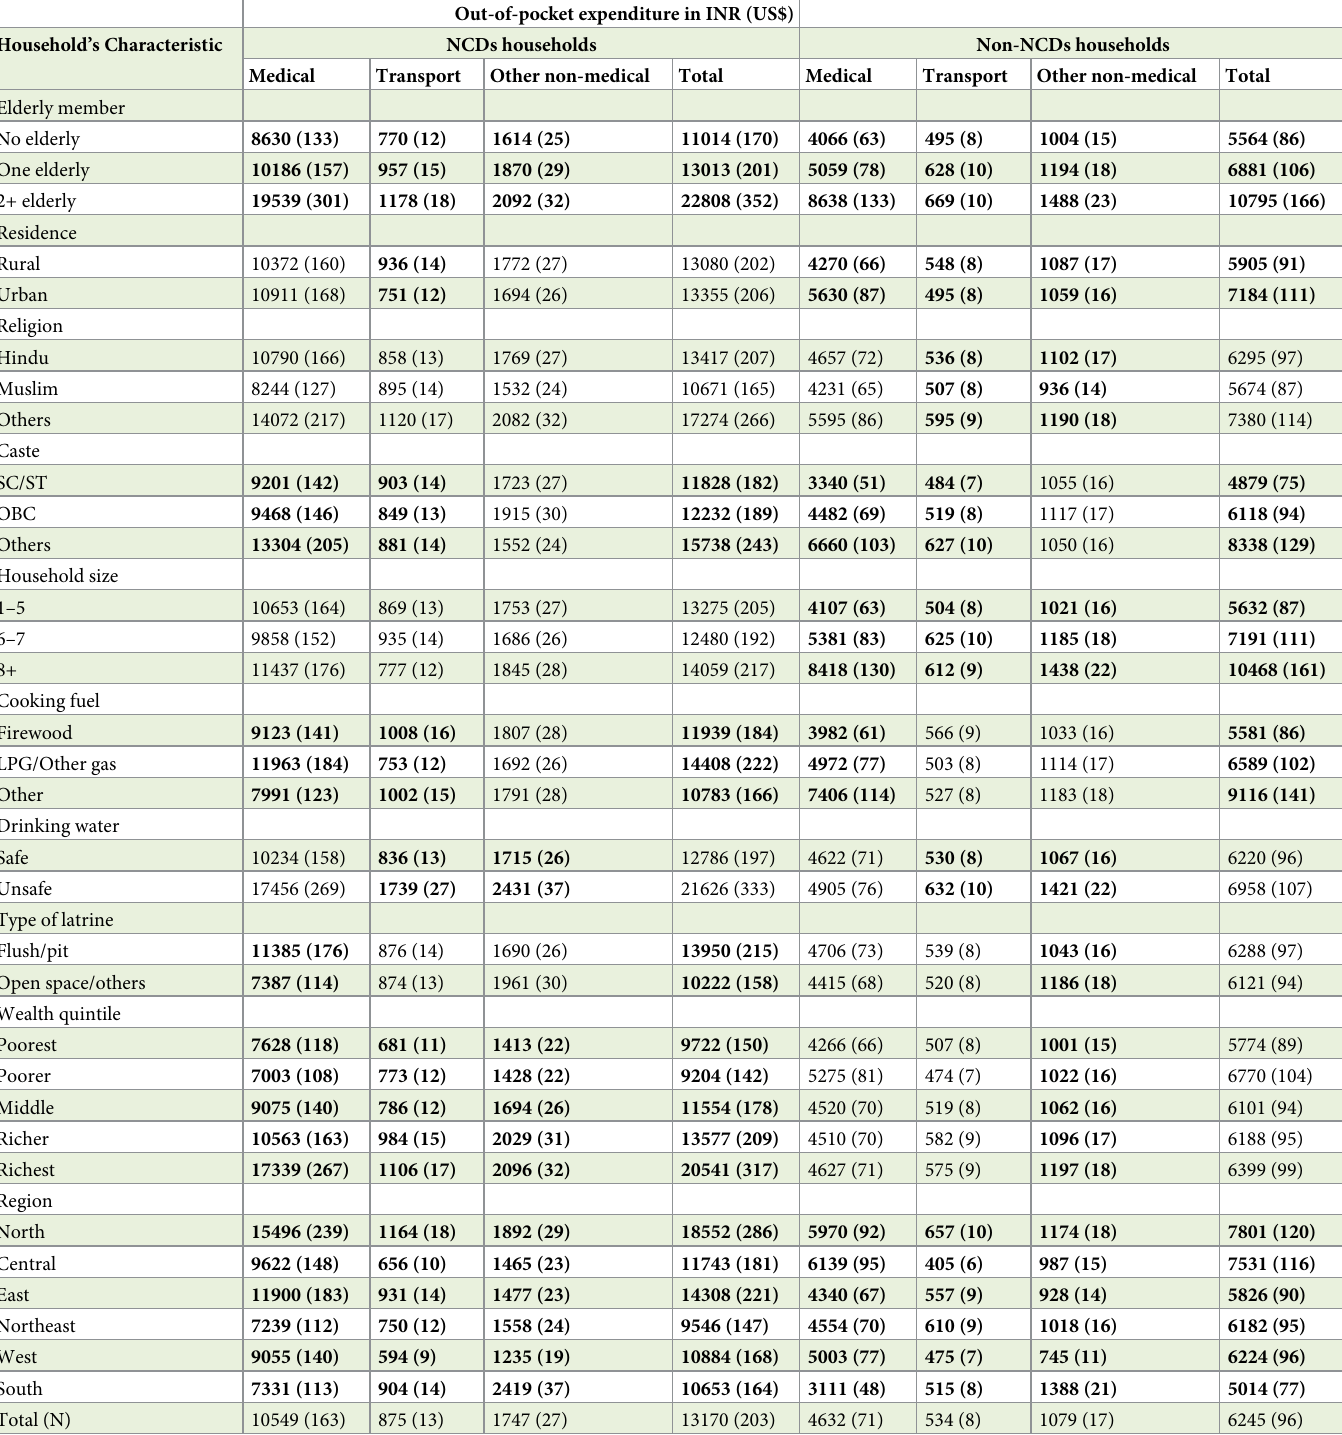
Table 2. Mean out-of-pocket expenditure by NCDs and non-NCDs households in public health care facility, NSSO survey